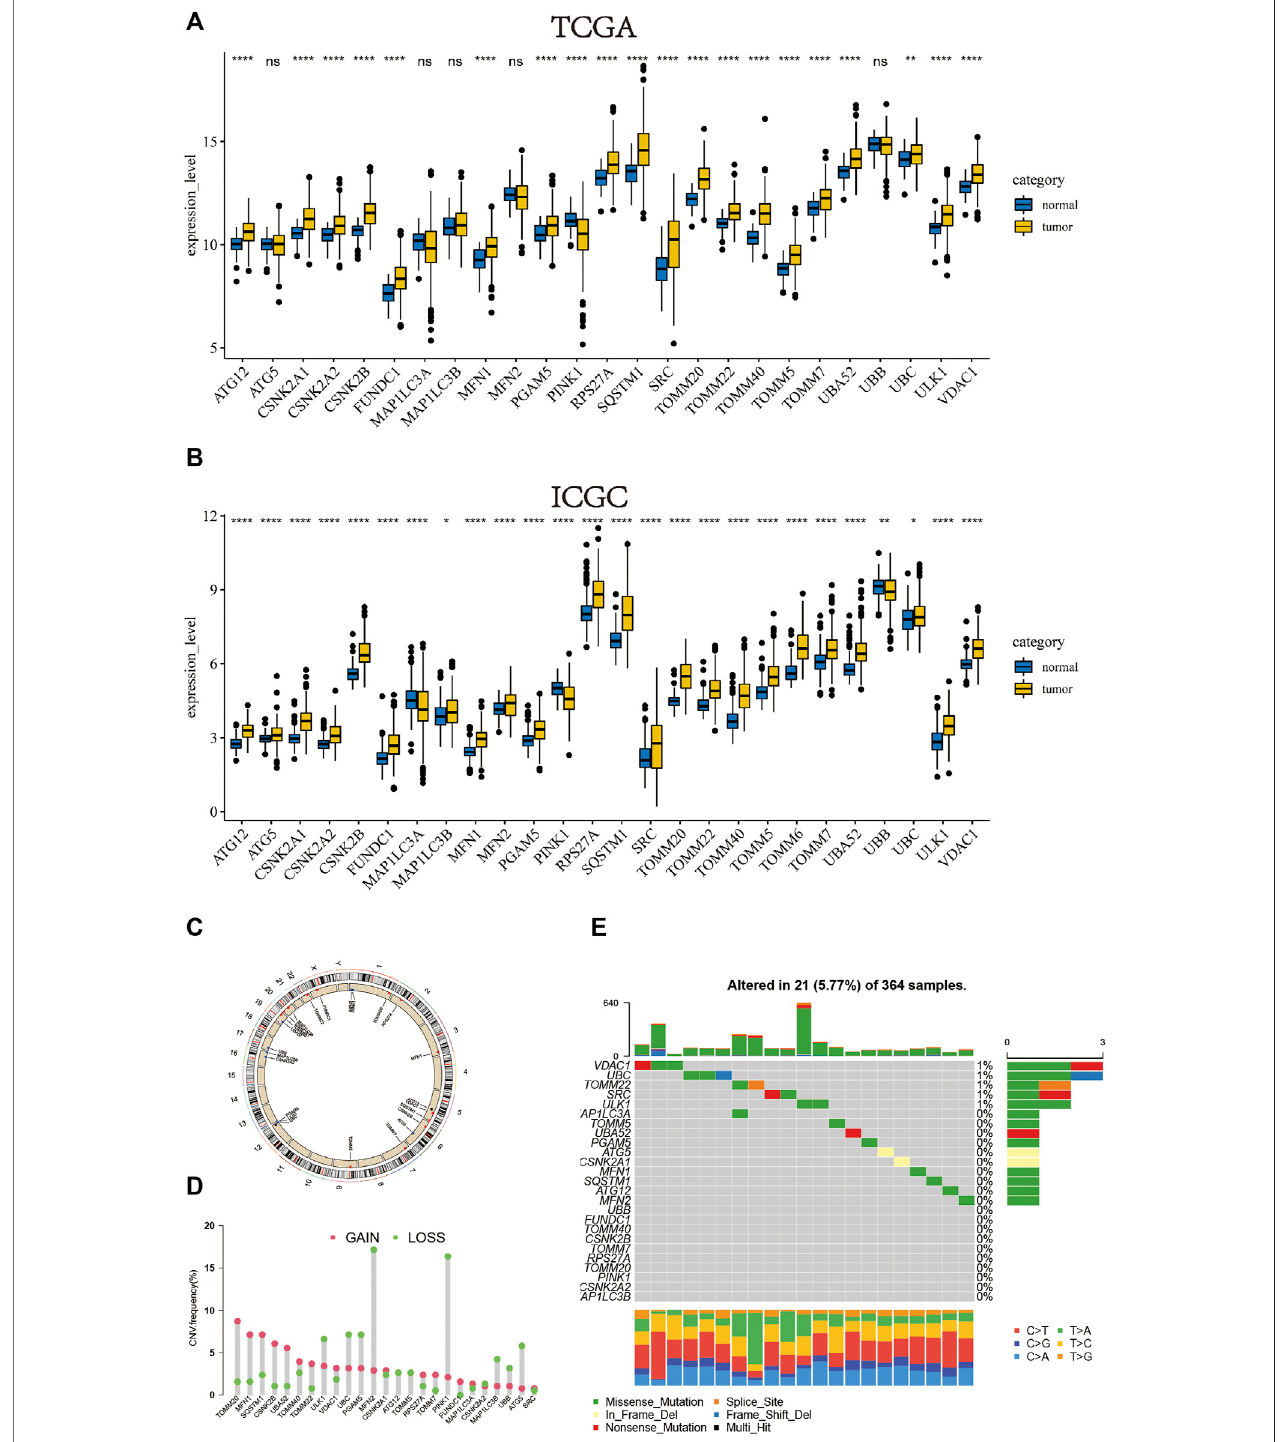
FIGURE 1 | In TCGA cohort, the boxplot of the expression level of the mitophagy regulators in normal and HCC samples (B) In ICGC cohort, the boxplot of the expression level of the mitophagy regulators in normal and HCC samples (C) The location of CNV alteration of mitophagy regulators on chromosomes using TCGA cohort (D) TheCNV variation frequency ofmitophagy regulators inTCGA cohort. Theheight ofthecolumn represented thealteration frequency. Thedeletionfrequency, green dot; The ampli fi cation frequency, red dot (E) The mutation frequency of mitophagy regulators in 364 patients with HCC from TCGA-LIHC cohort. Each column represented individual patients. The upper barplot showed TMB, The number on the right indicated the mutation frequency in each regulator. The right barplot showed the proportion of each variant type. The stacked barplot below showed fraction of conversions in each sample. The asterisks represented the statistical p value (* p < 0.05; ** p < 0.01; *** p < 0.001; **** p < 0.0001).